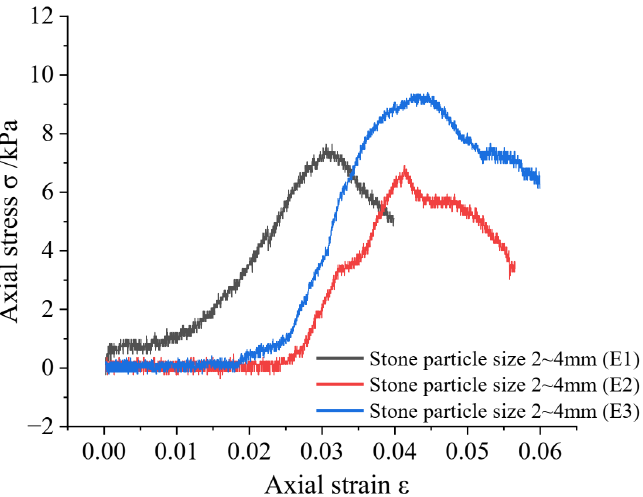
Figure 8. Stress–strain curve of soil–rock mixture sample with rock content of 60%.